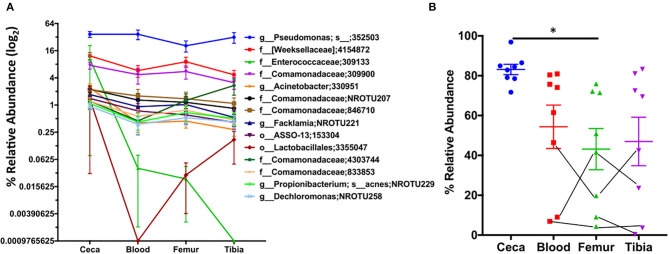
Spatiotemporal distribution of top 15 OTUs of ceca. The relative abundance of the top 15 OTUs of ceca at day 1 and their relative abundance in blood, femur, and tibia at day 1. (A) The relative abundance of top 15 OTUs of ceca (source) into the extraintestinal site (sink: blood, femur, and tibia) of chickens. Each point is the mean relative abundance (±S.E.) of eight chickens. (B) The cumulative abundance of the aforementioned 15 OTUs. Lines connecting the dots are the same chicken. Data are mean ± S.E. Samples were analyzed by ANOVA and Tukey's multiple-comparison test. *p < 0.05.